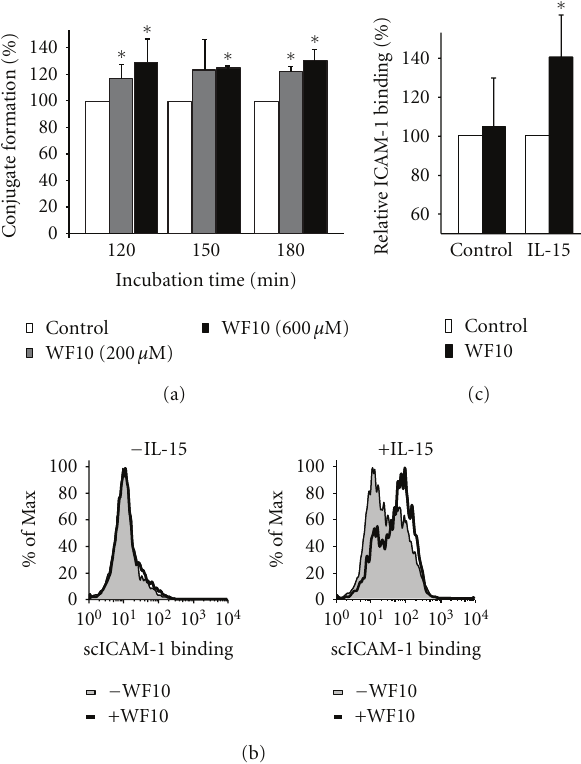
Figure 6: WF10 enhances NK cell adhesion. (a) NK cells and 721.221 cells were labeled with a di ff erent fluorescent dye, washed, and then incubated together with or without WF10 (200 or 600 μ M). At the indicated time points the mixed suspension was fixed with ice-cold 4% PFA and analyzed by FACS. The amount of NK: 721.221 conjugates formed by the cells without WF10 was used as a reference (100%). Average values and the standard deviation from 3 independent experiments with di ff erent blood donors are shown. (b, c) Freshly isolated NK cells were incubated with PE- conjugated ICAM-1 complex (scICAM-1) with or without WF10 for 3h. Samples were either left unstimulated (b, left panel), or treated with IL-15 (100 U/ml) (b, right panel). The amount of bound ICAM-1 complexes was measured by FACS. A representative experiment is shown in (b). The ICAM-1 binding to control cells (MFI 44 . 2 ± 20 . 4) and IL-15 stimulated cells (MFI 126 ± 60 . 3) was used as a reference (100%). (c) Average values and standard deviations from 5 independent experiments with di ff erent blood donors are shown. The ratio of each outcome and its control was tested against a value of 1 (equality) by two-sided single-sample t - tests ( ∗ P < .